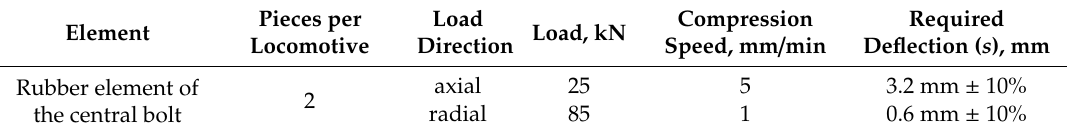
Table 2. Requirements for the series 441 / 444 locomotive central bolt rubber-metal spring.